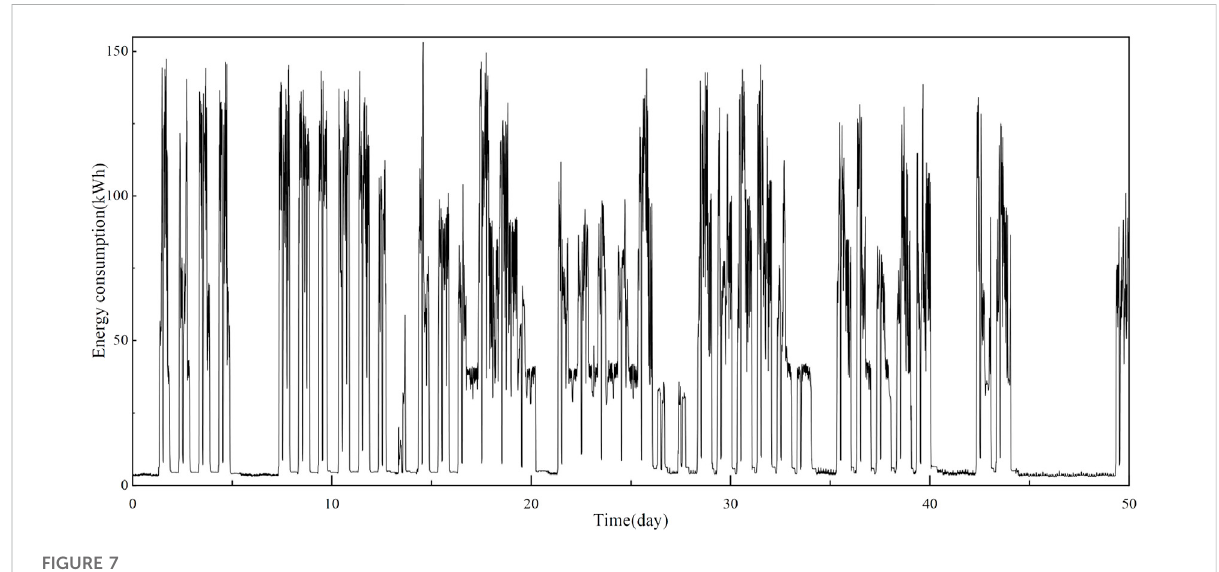
FIGURE 7 Operational cost index data for 50